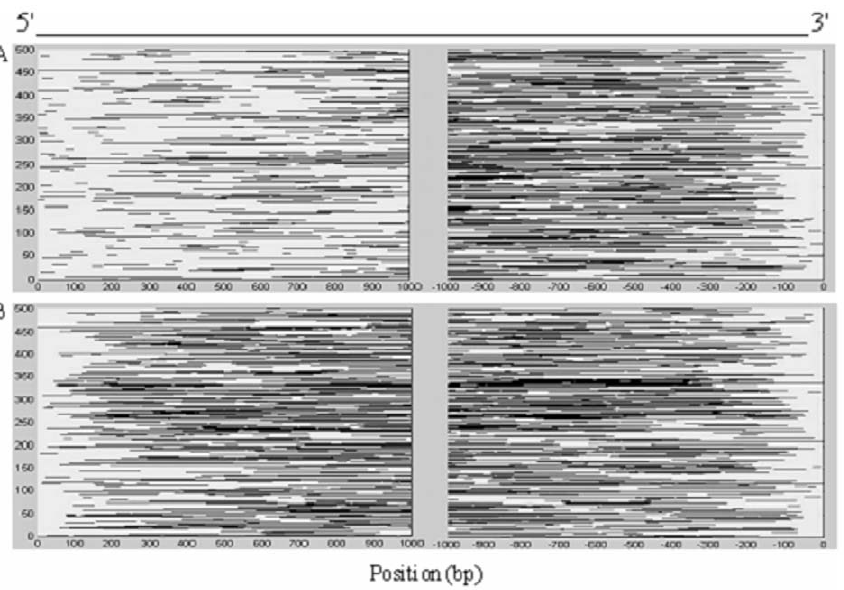
Figure 4. Repetitive elements in the introns. The repetitive elements are represented as black lines in the introns, where other regions are represented as gray spaces. The values along the vertical coordinates represent the numbers of introns (500 introns are selected randomly from the first introns and other introns, respectively). The directions of introns are from 5 9 -ends to 3 9 -ends. The nucleotide positions are relative to the splice sites. (A) Repetitive elements in the 5 9 -ends (left panel) and 3 9 -ends (right panel) of the first introns. (B) Repetitive elements in the 5 9 -ends (left panel) and 3 9 -ends (right panel) of the other introns position. ‘0’ at 5 9 -end and 3 9 -end denotes the position of 5 9 -splice site and 3 9 -splice site of the introns, respectively.